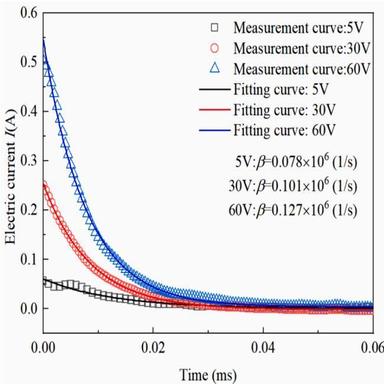
The envelope curve of the current decay waveform of the PMN-PT composite disk under the short-circuited condition with different AC driving voltages.